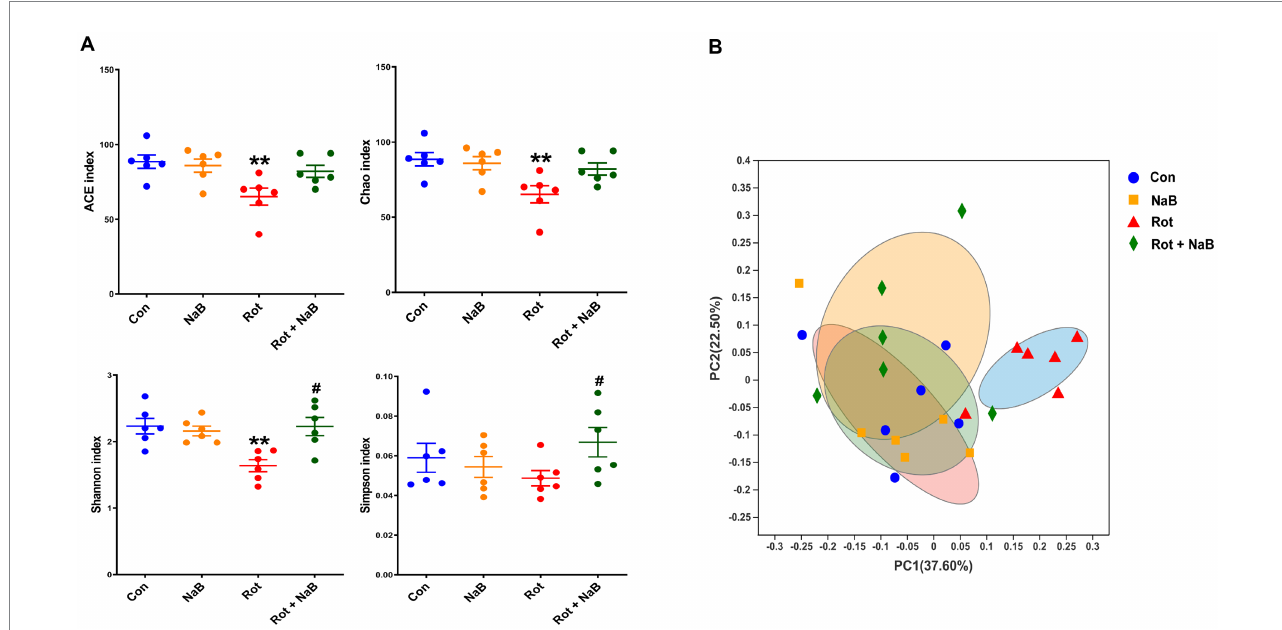
FIGURE 4 NaB reverses rotenone-induced alteration of gut microbial alpha and beta diversity. (A) Bar plots of alpha diversity indices, including ACE, Chao, Shannon, and Simpson index. (B) PCoA plots of the beta-diversity with Bray-Curtis measures. n = 6 per group. The data represent the mean ± SEM. ** p < 0.01 vs. Con group; # p < 0.05 vs. Rot group. Con: control; NaB: sodium butyrate; PCoA: principal coordinate analysis; Rot: rotenone.